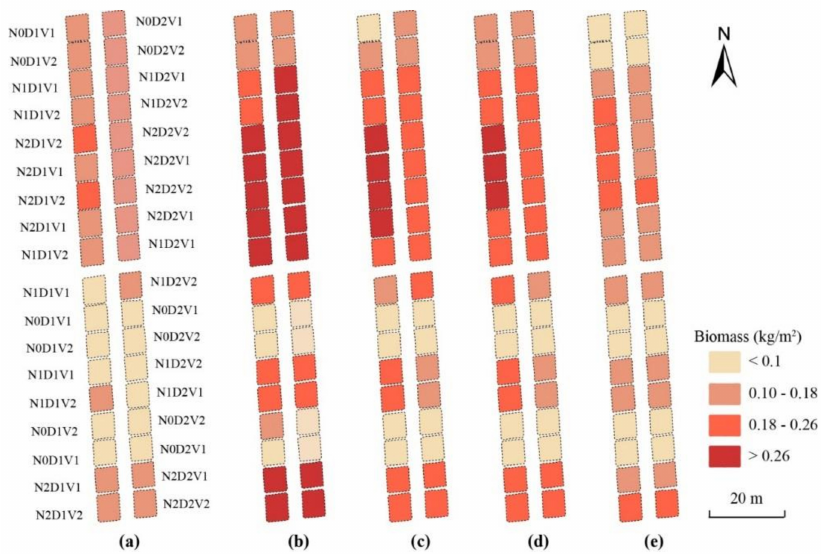
Figure 13. Leaf biomass mappings using the relationship between MTVI 2 and leaf biomass at different growth stages: ( a ) jointing stage; ( b ) booting stage; ( c ) heading stage; ( d ) anthesis stage; and ( e ) filling stage. N is nitrogen rate (N0 = 0, N1 = 150, N2 = 300 kg/ha). D is row spacing (D1 = 25, D2 = 40 cm). V represents the wheat varieties Shengxuan 6 (V1) and Yangmai 18